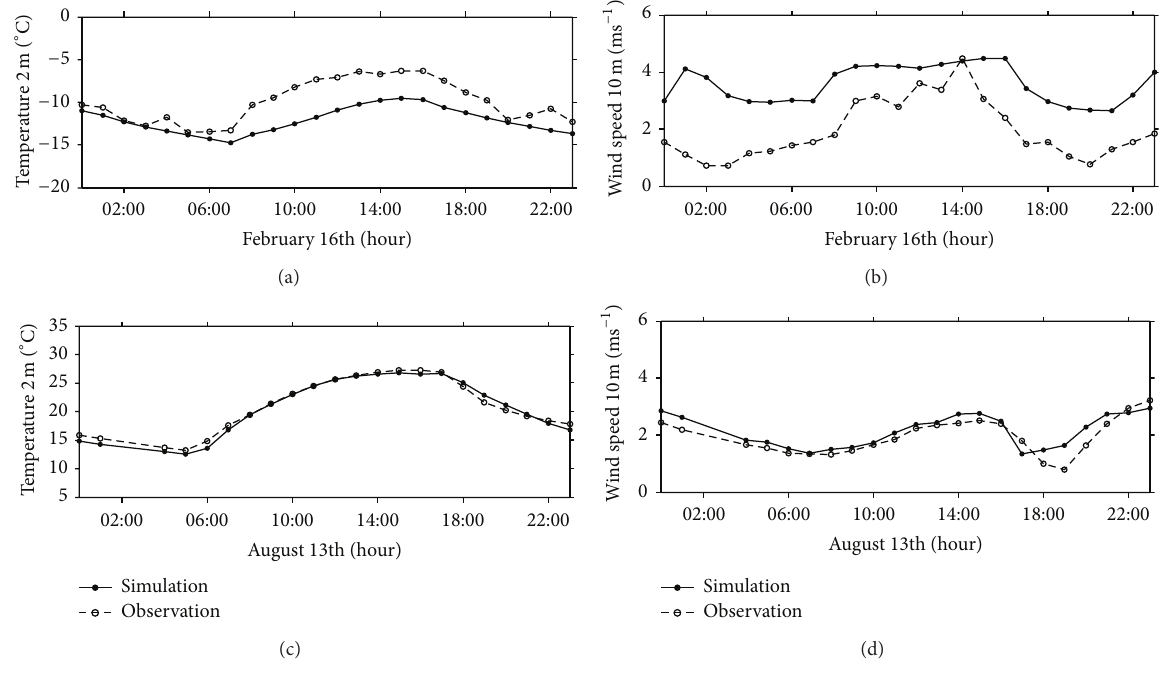
Figure 4: Time series of observed and WRF-simulated results: (a, c) 2-m temperature; (b, d) 10-m wind speed; (a, b) simulation on 16 February 2012; (c, d) simulation on 13 August 2012. The observation is the mean value of 17 meteorological stations around Shenyang, while the simulation is the average of the values taken at the grids nearest to the